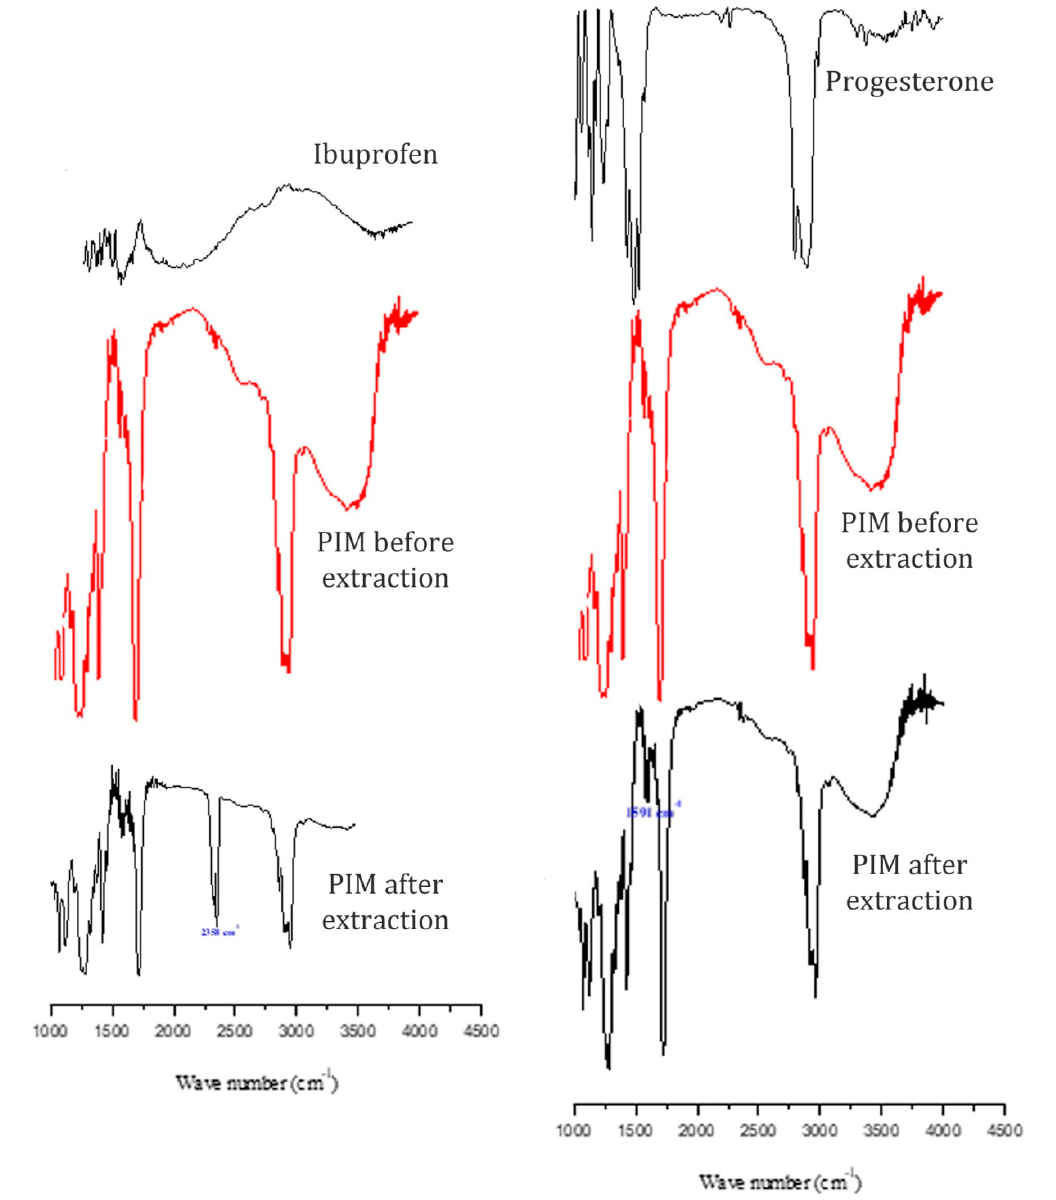
Figure 6. FT-IR spectra of different PIMs nefore and after extraction of Ibuprofen and